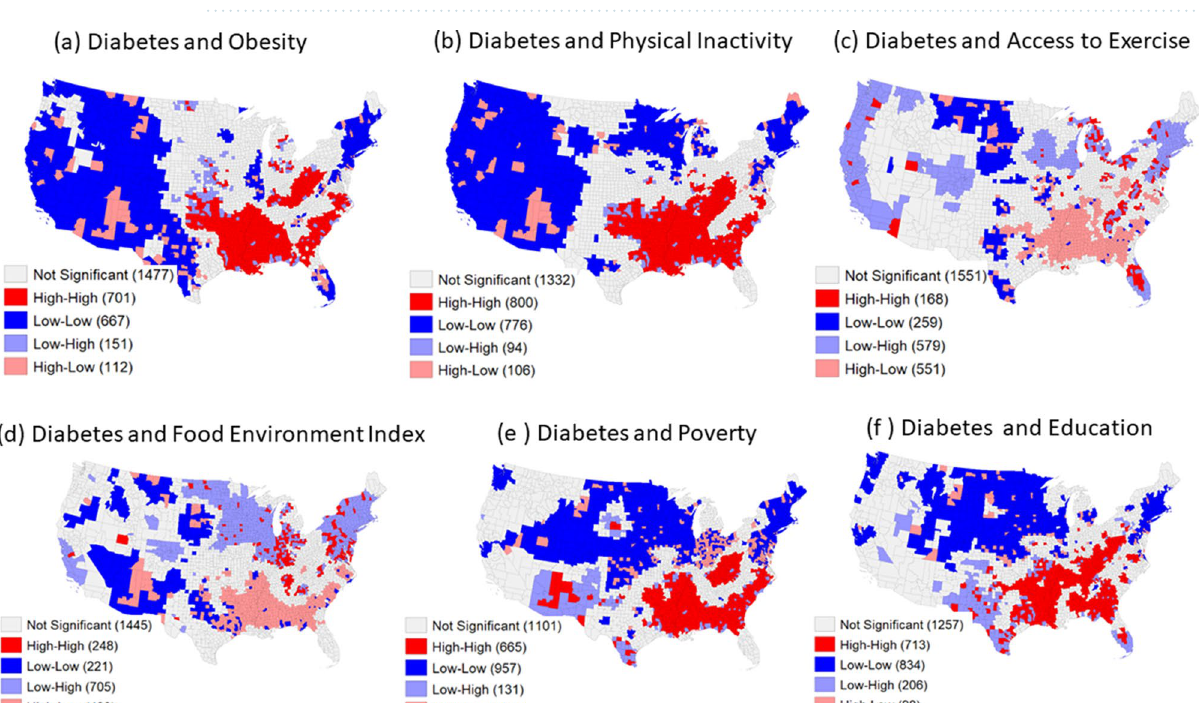
Figure 3. Bivariate LMI cluster of diabetes and ( a ) obesity; ( b ) physical inactivity; ( c ) access to exercise; ( d ) food environment index; ( e ) poverty; and ( f ) education. Maps were generated in GeoDa (version 1.14), an open source software for geodata analysis 45